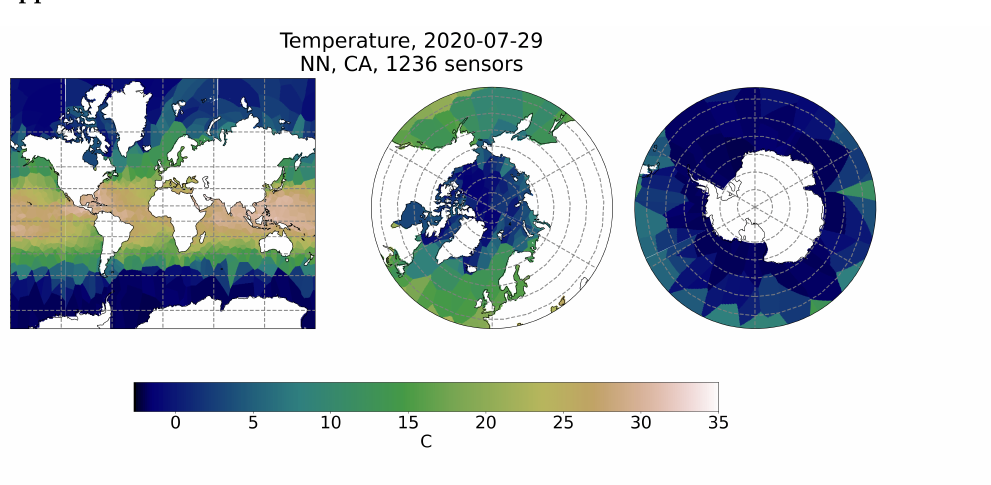
Figure A4. Reconstructed field by the Nearest Neighbor (NN) method from 1236 measurements with placement using the Concrete Autoencoder